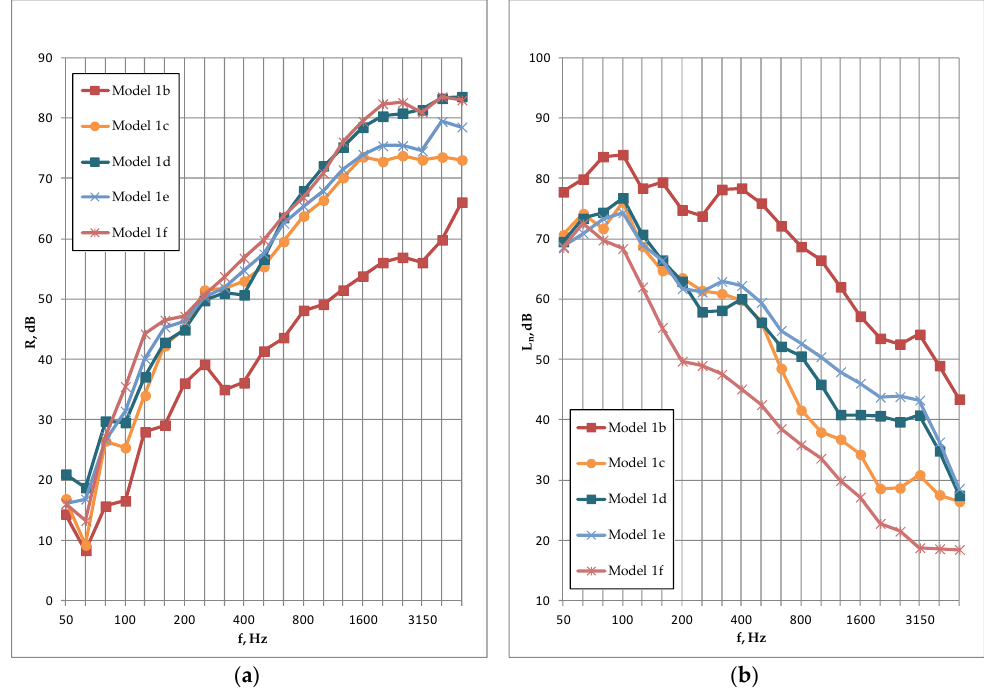
Figure 10. Airborne ( a ) and impact ( b ) sound insulation test results of all models of the wooden floor compared to the basic construction (model 1b).